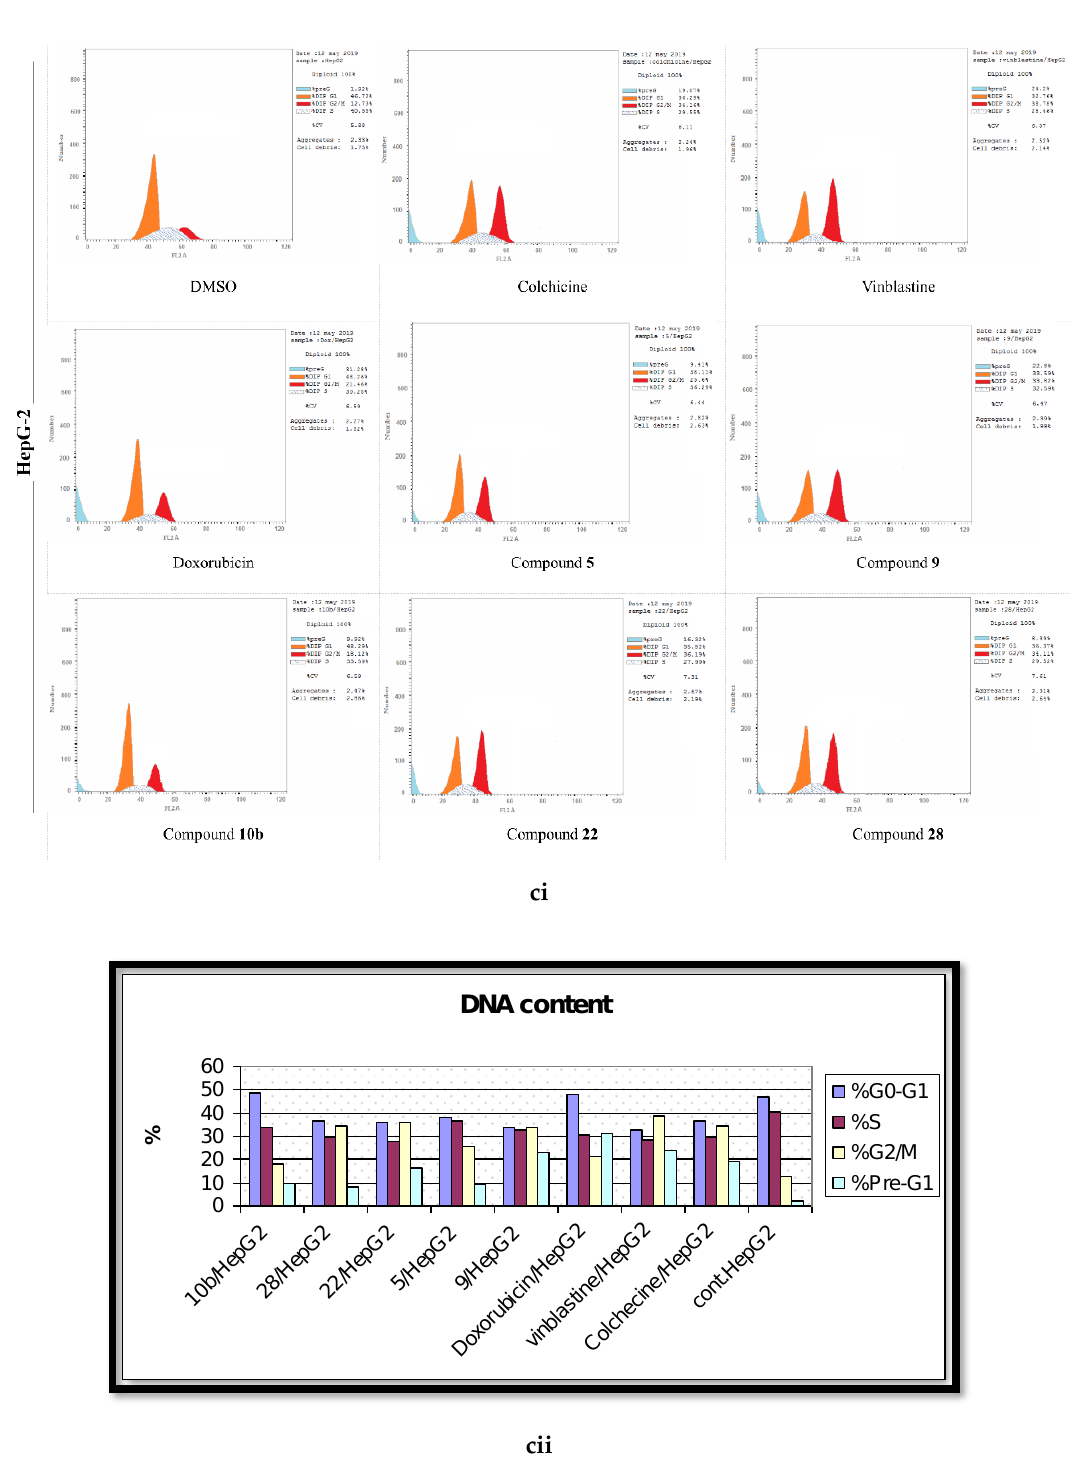
Figure 6. The effects of the DMSO, the standard anticancer drugs, and the synthesized compounds on the cell cycle distribution of the ( a ) MCF-7, ( b ) HCT, and ( c ) HepG-2 cancer cell lines. ( i ) FACS-mediated cell cycle analysis, ( ii ) A histogram shows the percentages of the DNA content in different cell cycle phases.